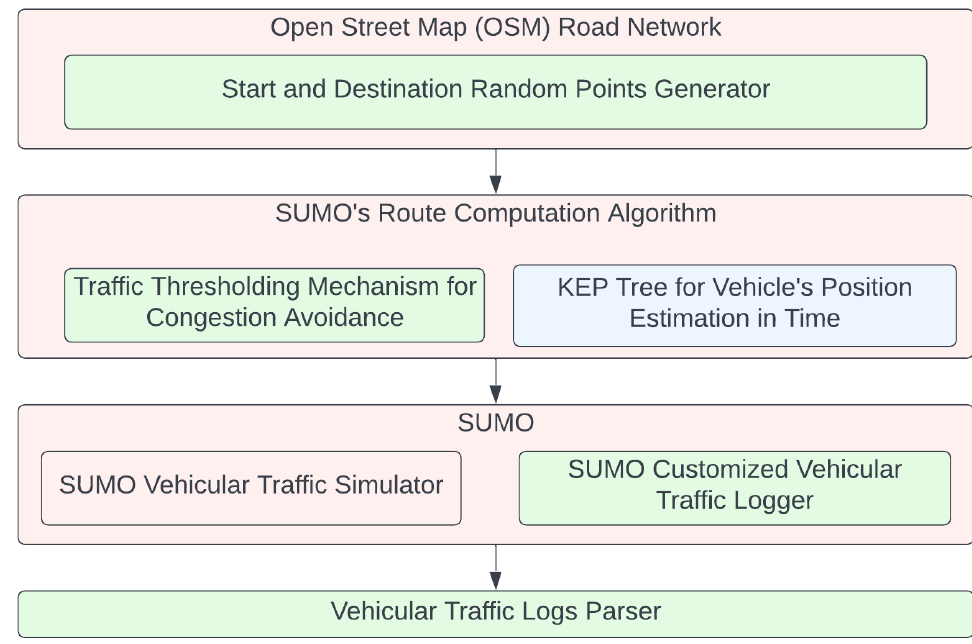
Figure 3. Vehicular traffic congestion avoidance implementation